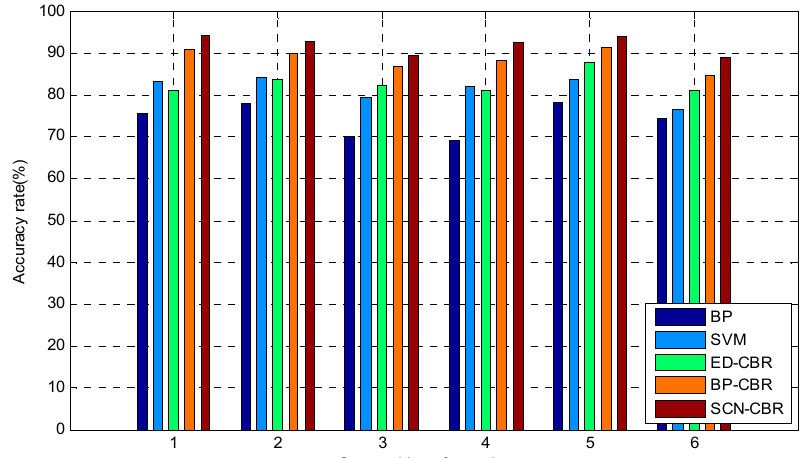
Figure 4. Single fault detection accuracy (%).